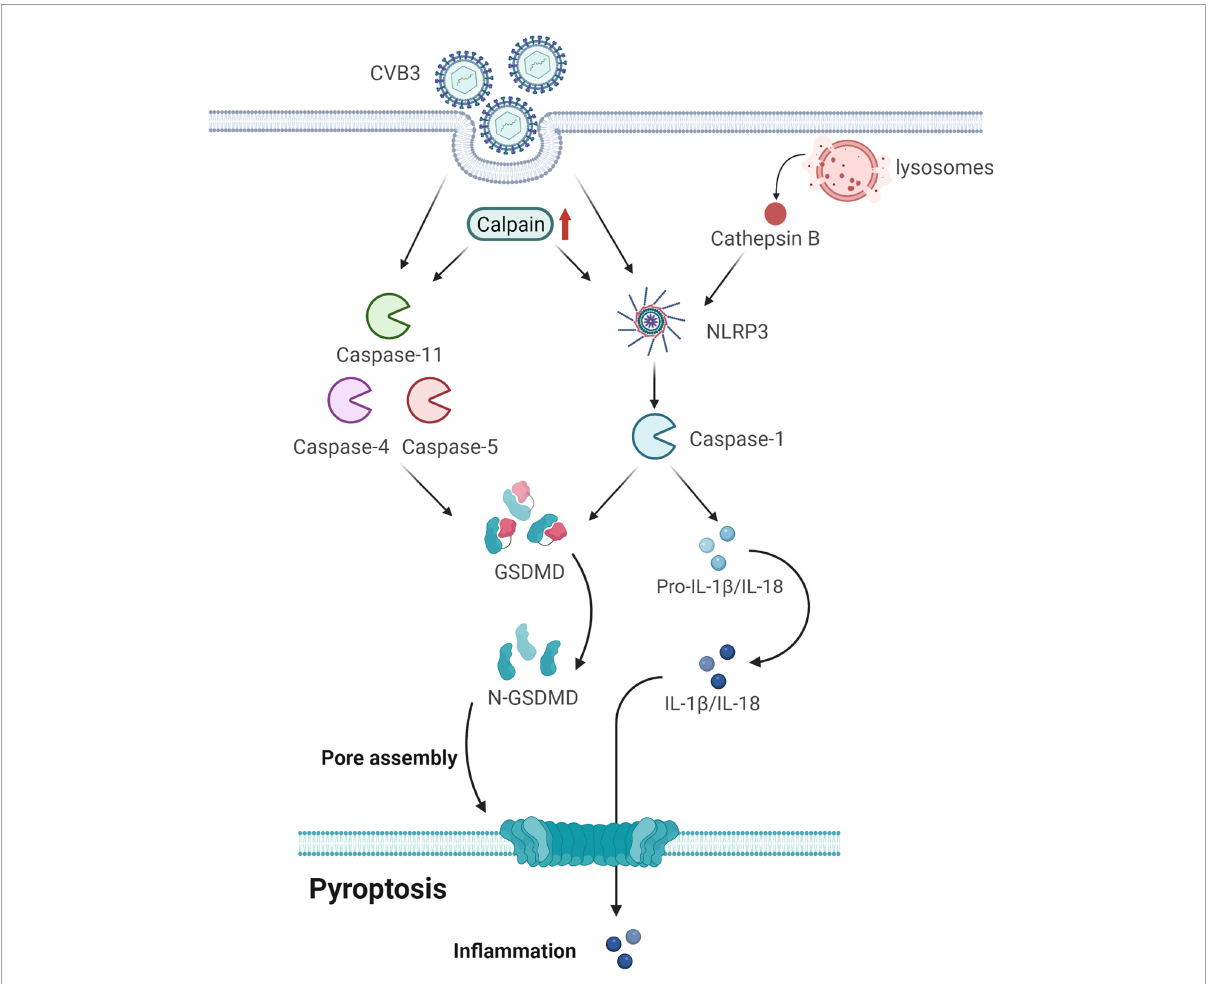
FIGURE3 Gasdermin D (GSDMD) forms membrane pores to cause pyroptosis. CVB3 infection initiates pyroptosis by canonical caspase-1-dependent and non-canonical caspase-4/5/11-mediated pyroptosis pathways. In the canonical pyroptosis pathway, cells recognize intracellular